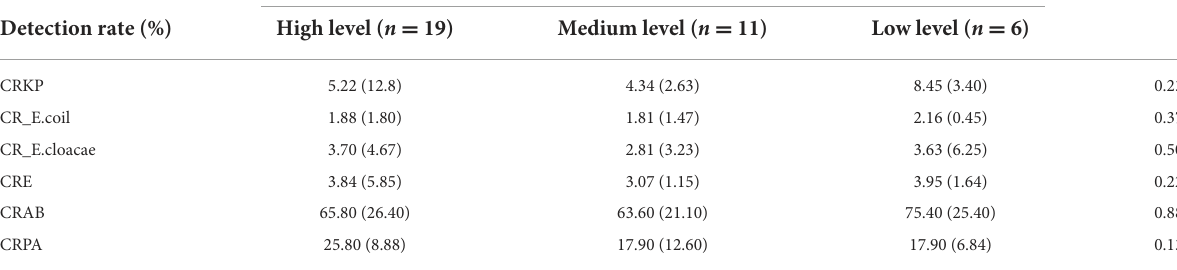
TABLE 2 The detection rate of GRNB from different hospitals economic level